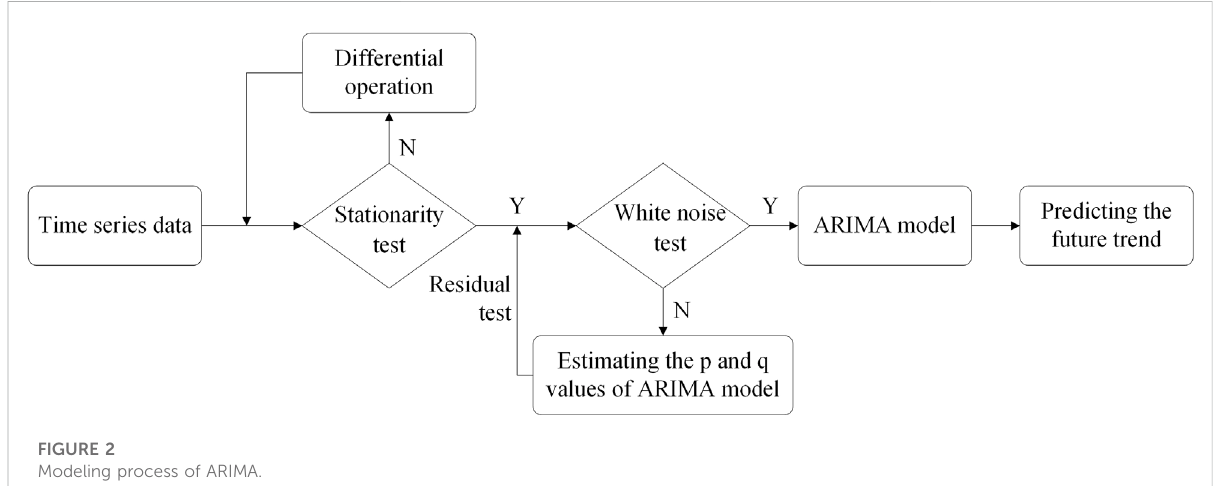
FIGURE 2 Modeling process of